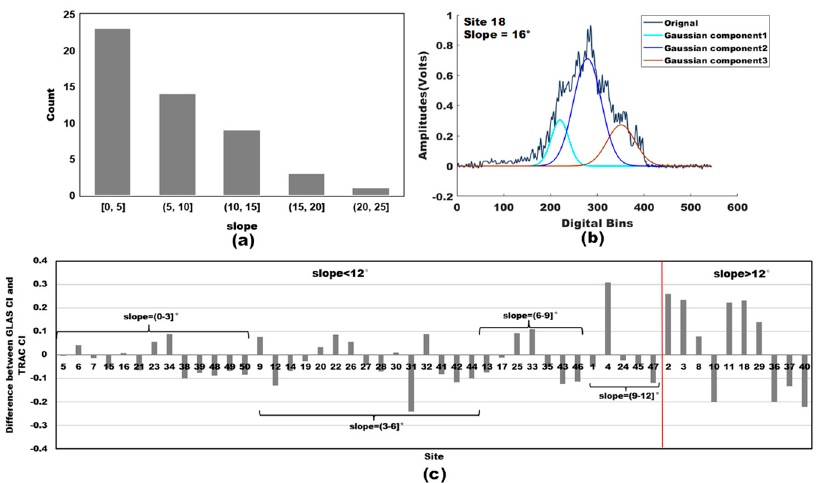
Figure 6. ( a ) Slope information of GLAS footprints over Saihanba National Forest Park. ( b ) An example of GLAS received waveform with a large slope (i.e., slope = 16 ◦ ); three Gaussian components represent different detected objects. ( c ) The variation of error with slope; error means the difference between GLAS CI and TRAC-measured CI.